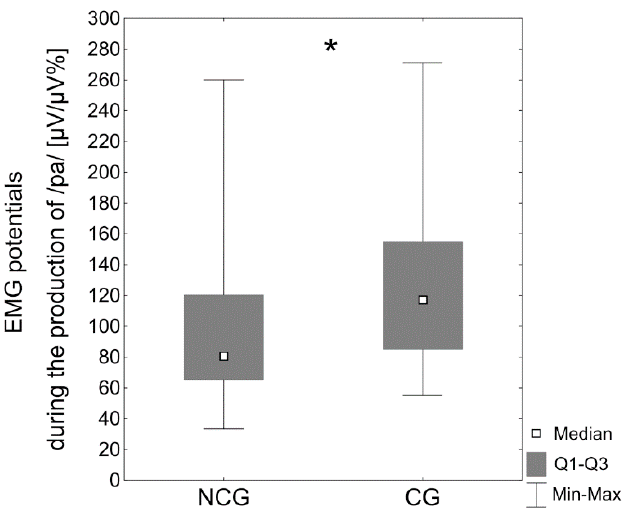
Figure 4. EMG potentials of the upper lip [µV/µV%] during production of the phoneme /p/ with the vowel /a/ in the noncleft group (NCG) and the cleft group (CG); * p <